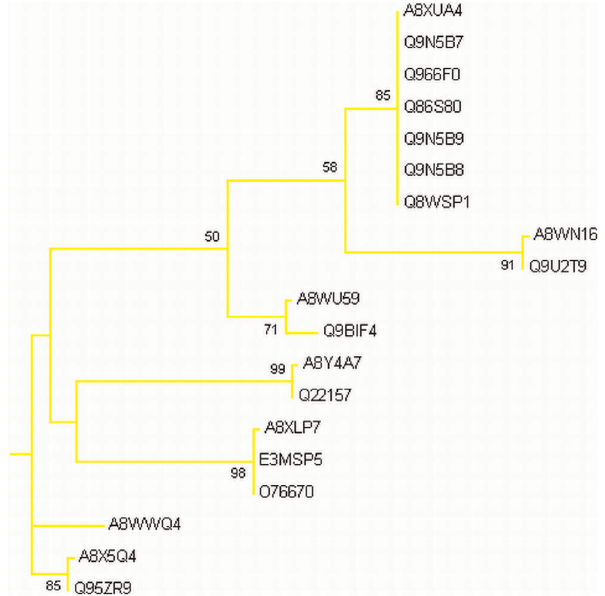
Figure 11. Group VII. Tree showing all proteins included in this